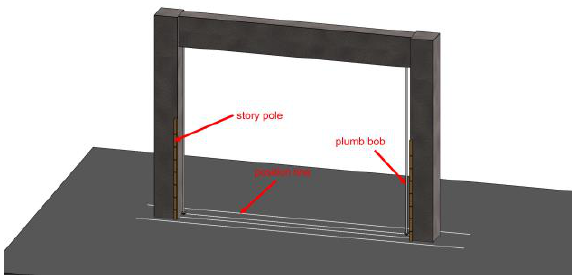
Figure 4. Process content modeling based on the infill wall masonry process design model.